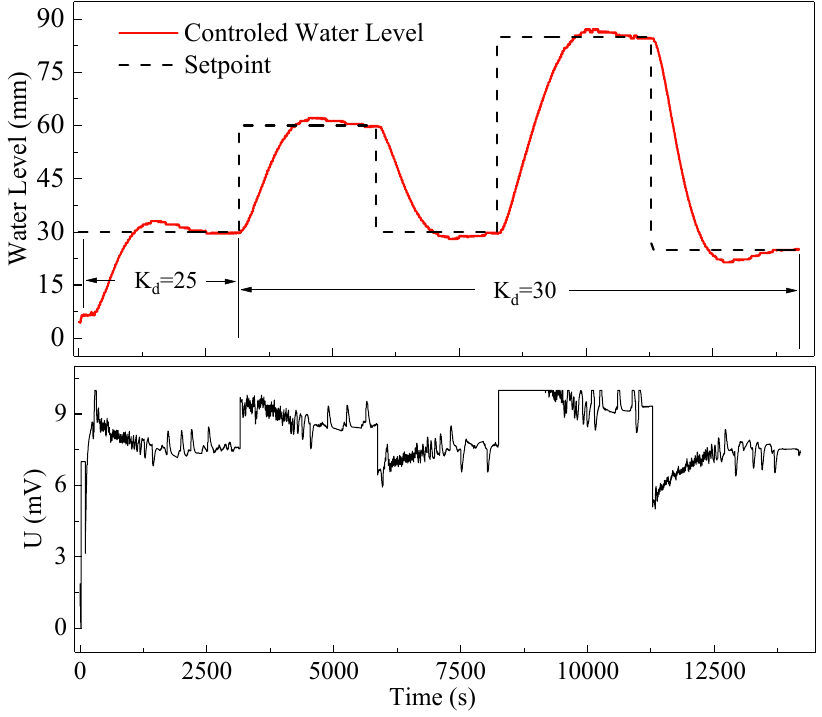
Figure 13. Water level tracking experiment with conventional ADRC controller.